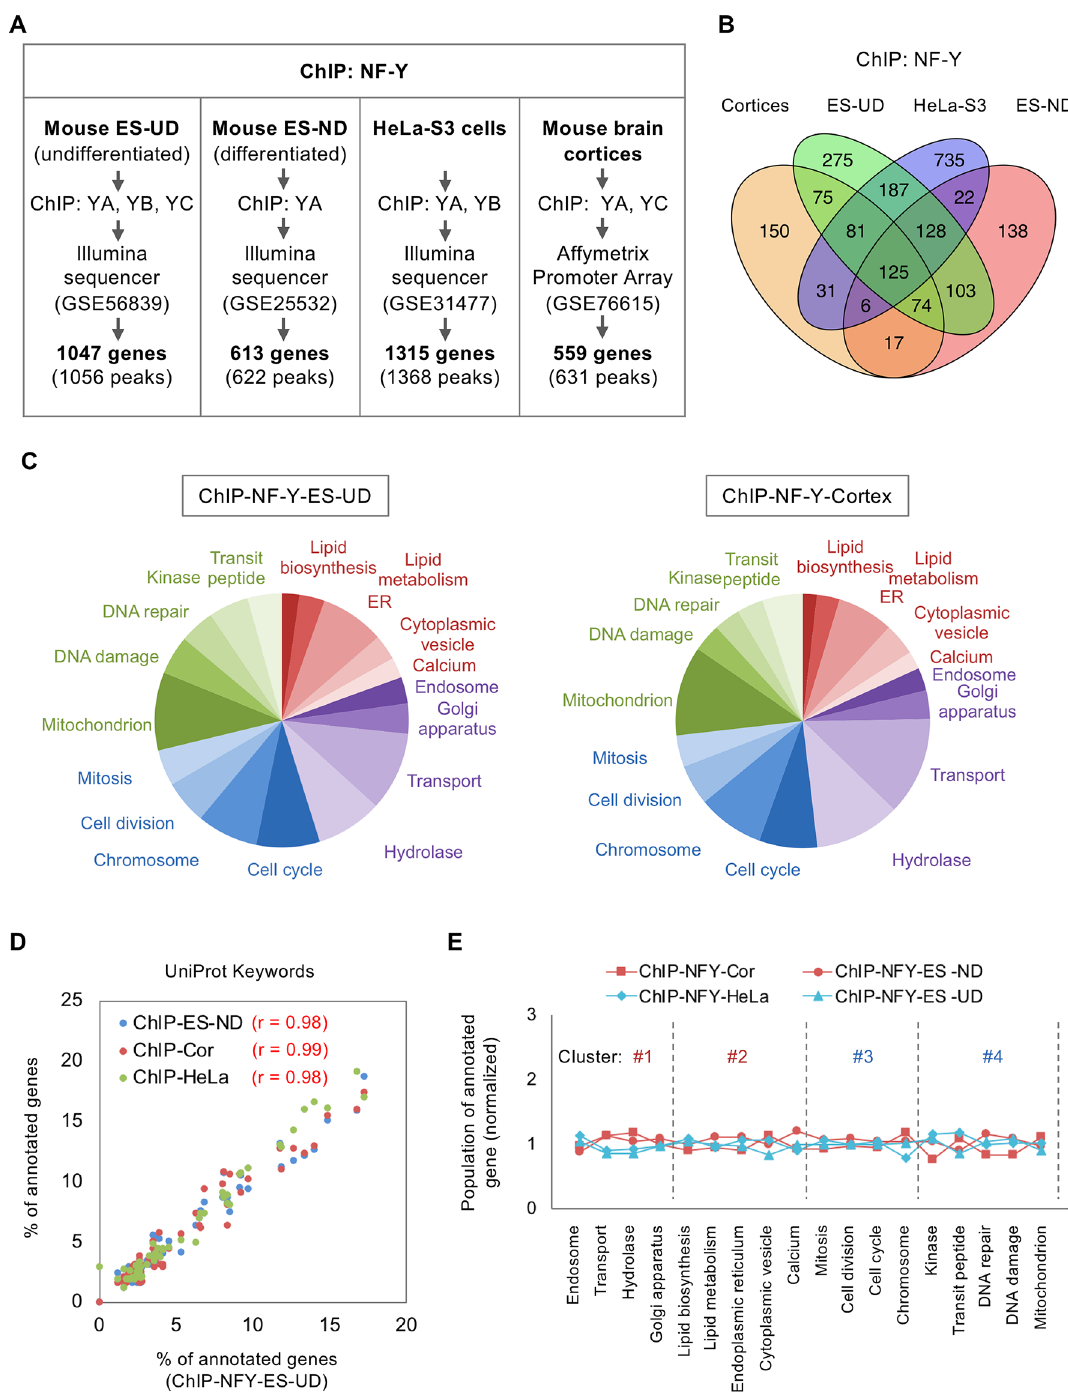
Figure 5. Analysis of NF-Y ChIP data in different types of cells. ( A ) ChIP data from mouse undifferentiated ES (ES-UD), nuerally differentiated ES (ES-ND), HeLa-S3 cells and mouse brain cortices were analyzed by a R package “ChIPpeakAnno”, and 600–1300 target genes of NF-Y were identified. ( B ) Comparison of the NF-Y target genes identified by ChIPs. Significant overlaps were observed even in different types of cells. ( C ) Pie graphs for the populations of annotated NF-Y-ChIP genes from ES-UD and brain cortices. They were mostly identical. ( D ) Scatter plot for the populations of annotated NF-Y-ChIP genes. Quite high correlations were observed among the four types of cells. ( E ) Overall comparison of the populations of annotated genes in CL #1–4. No distinct difference was observed in these